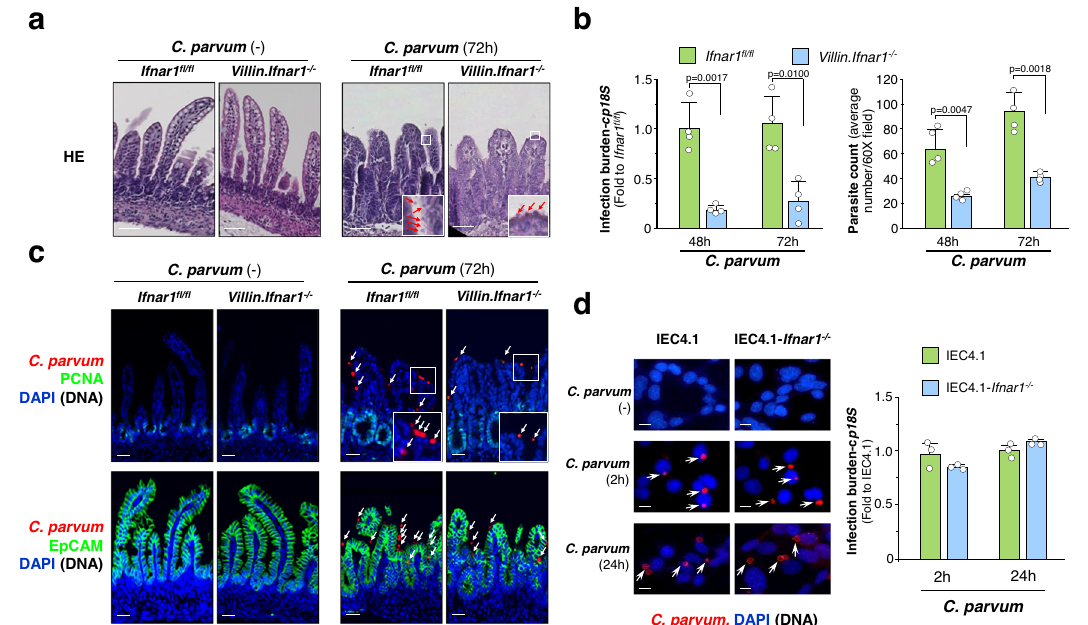
Fig. 1 | C. parvum infection in conditional intestinal epithelial Ifnar1 knockout mice and IEC4.1 cell cultures. a HE morphological features of small intestine of Ifnar1 fl / fl and Villin.Ifnar1 − / − neonatesfollowing infection. Neonatalmice(5days old) were orally inoculated with C. parvum oocysts (10 6 oocysts per animal) and ileal epithelium(4cmofsmallintestinetissuefromtheileocecaljunction)wascollected (72h p.i.) Representative HE images from four independent experiments are shown. Insets are higher magni fi cation of the boxed regions showing the parasites (arrows). Bars = 50 µ m. b C. parvum intestinal infection burden in Ifnar1 fl / fl and Villin.Ifnar1 − / − mice. Neonatal mice were inoculated with C. parvum oocysts (10 6 oocysts per animal) for 48h and 72h. Infection burden was evaluated by RT-qPCR of cp18S gene in the isolated intestinal epithelium (fold changes to Ifnar1 fl / fl nor- malized to host Gapdh ) and parasite counting of intestine sections after immu- no fl uorescent staining of C. parvum (average number/60X fi eld). Data are presentedasmeanvalues±SD,compiledfrom4independentexperimentsandthe